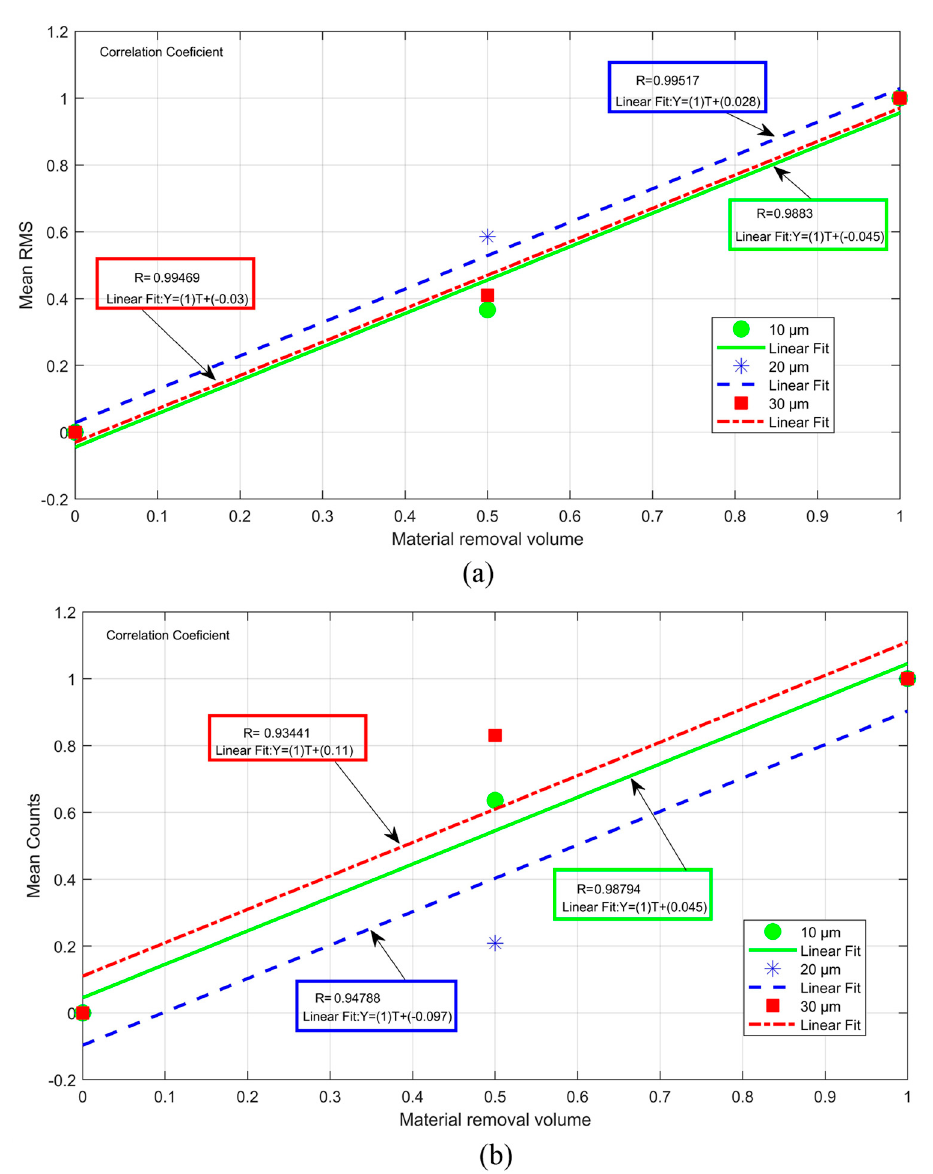
Figure 14. Correlation between the statistics and the volume of material removed ( a ) RMS and ( b )